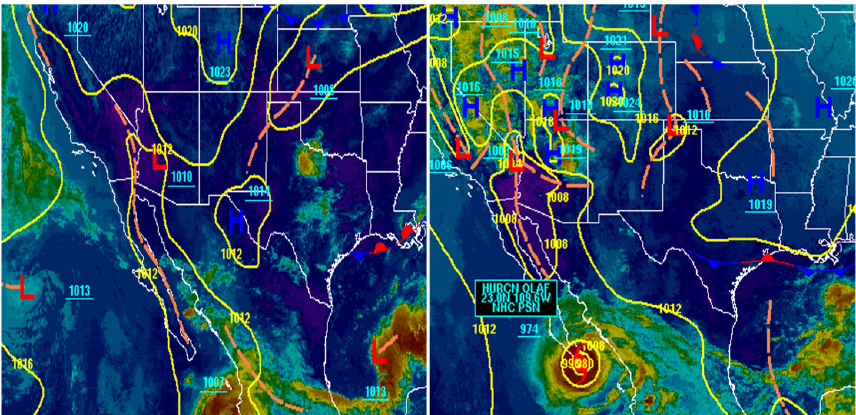
Figure 14. The satellite composite of 7 September 2021, at 1500 Z showing the presence of a high- pressure system (marked as blue H) over the study area (left), and 10 September 2021, at 03 Z showing hurricane Olaf (marked as red hurricane within yellow circle) near the southern coast of Baja California.